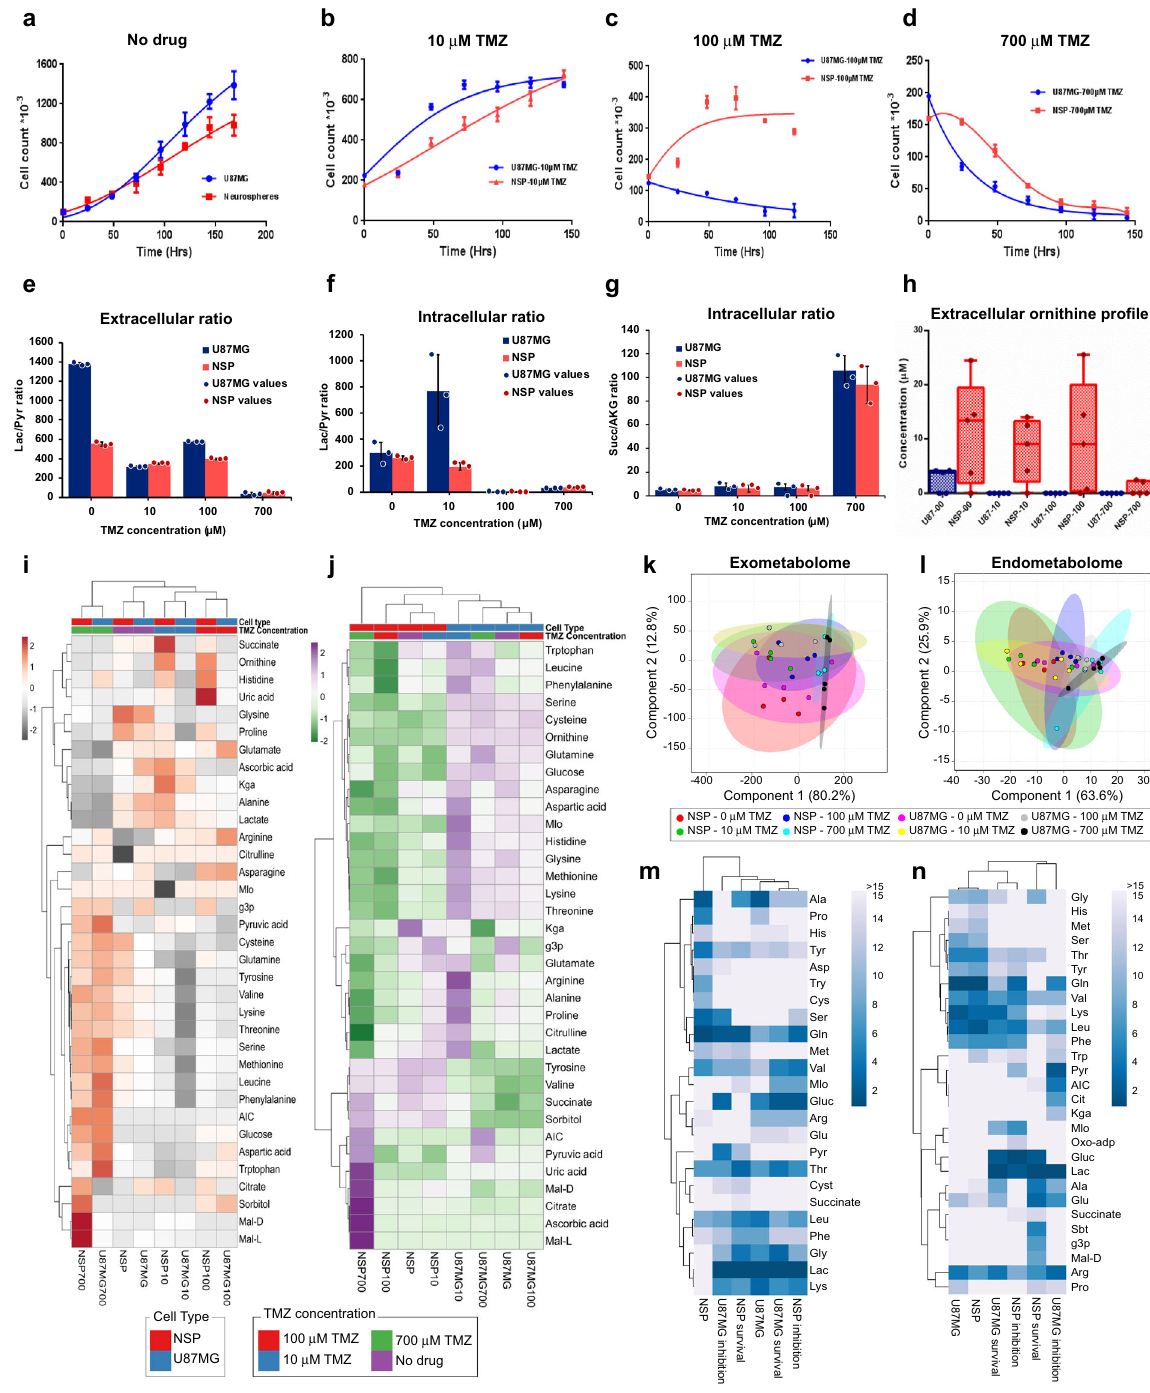
Fig. 1 Metabolomic characterization of temozolomide resistance. Growth of U87MG and NSP in the absence of TMZ ( a ), in the presence of 10 μ M TMZ ( b ), 100 μ M TMZ ( c ), and 700 μ M TMZ ( d ). The growth rates of U87MG and NSP were calculated using the Gompertz function (lines inside the dot plots) using GraphPad Prism Software. e Extracellular lactate (Lac) to Pyruvate (Pyr) ratio and f Intracellular Lac/Pyr ratio. Absolute concentration ratios (shown as bar plots) were calculated and plotted to delineate Warburg effect. g Intracellular succinate (Succ) to a-keto glutarate (AKG) ratio. The absolute levels were normalized to cell number to estimate the values plotted. h Extracellular ornithine levels. NSP cells show higher levels of Ornithine irrespective of TMZ treatment, a phenotype that is inherent in NSP. The boxes in the boxplot indicate the upper and lower quartiles of the data and the middle line is the median with the whiskers extending to 1.5× interquartile range. Dots are the sample data points ( n = 5 for time points 0 h, 24 h, 48 h, 72 h, and 96 h). i Exo-metabolome pro fi le and j Endo-metabolome pro fi le comparison across U87MG and NSP cells. The heatmap is plotted using absolute concentration (C) differences between 96 h (t96) and 0 h (t0), and calculated as C t96 – C t0 . These values are processed to indicate Z -score (color scale) using Euclidean clustering. k Exo-metabolome PCA and ( l ) endo-metabolome PCA showing the clusters according to the TMZ concentrations used for treatment as 0 μ M, 10 μ M, 100 μ M, and 700 μ M. m and n . VIP scores for growth essential metabolites according to Exo-metabolome ( m ) and Endo-metabolome ( n ) pro fi les. Error bars indicate mean ±